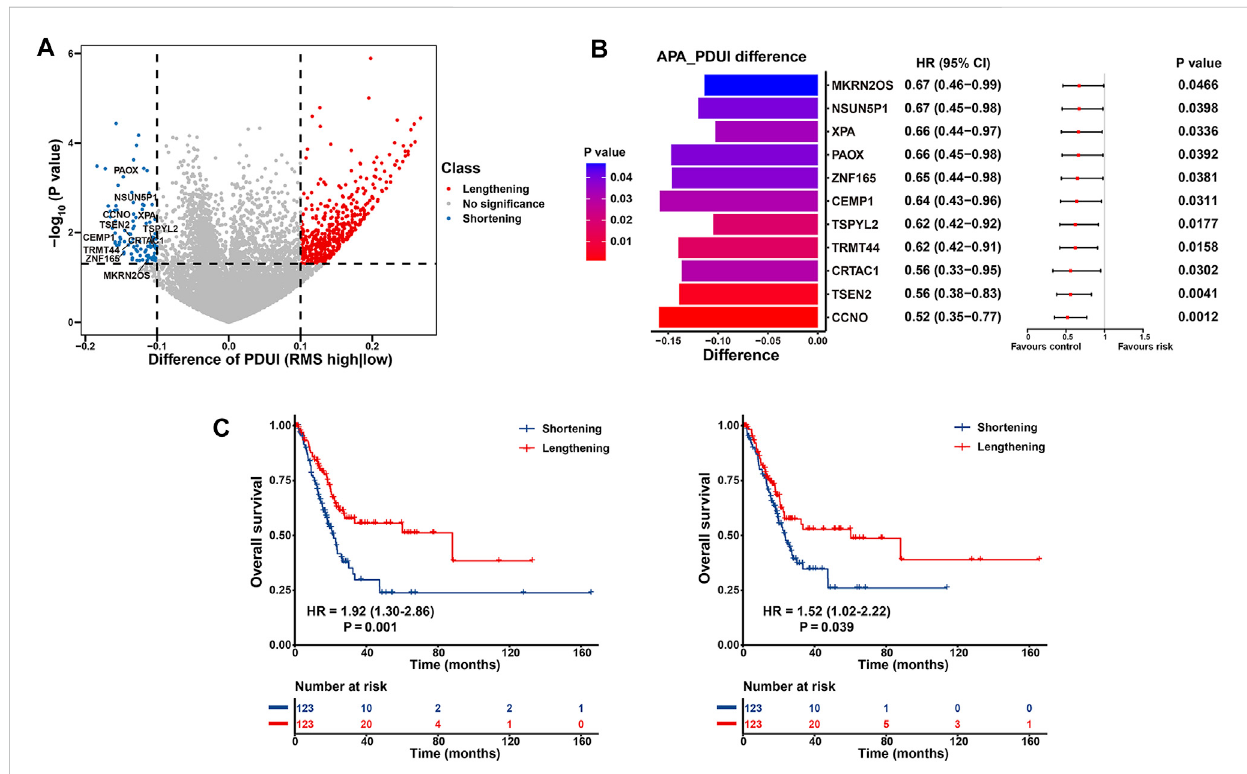
FIGURE 9 Post-transcriptional characteristics related to the RMS of BCa patients in the TCGA-BLCA cohort. (A) Volcano plot representing signi fi cantly differences in the PDUI of each gene between RMS-high and -low groups. (B) Bar graphs showing transcripts with shortening 3 ′ UTR events in RMS-high group. Forest plots showing univariate Cox regression analysis for genes with differential PDUI between RMS-high and -low group. (C) Kaplan-Meier curve showing OS between PDUI lengthening and PDUI shortening of CCNO and